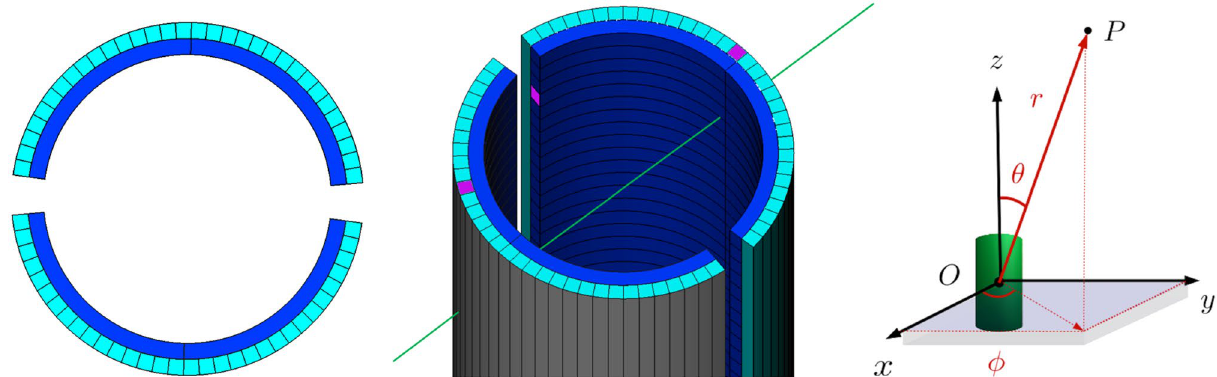
Figure 1. Schematic arrangement of the scintillating elements of the cylindrical detector and an example of a muon passing through the detector illuminating (in violet) its scintillators. On the right, the spherical coordinate system used for